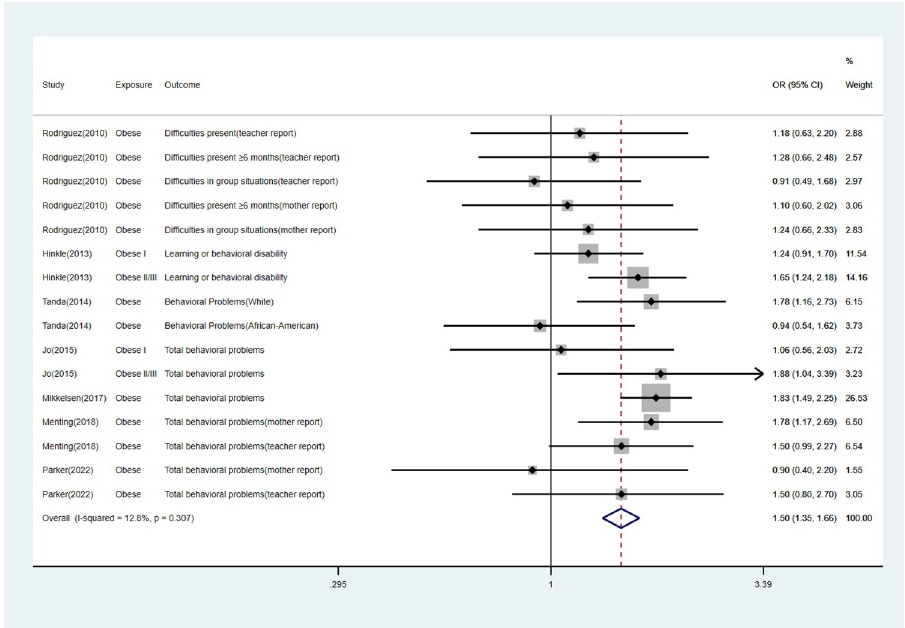
Fig 6. Forest plot for obese mothers and their offspring’s risk of behavioral